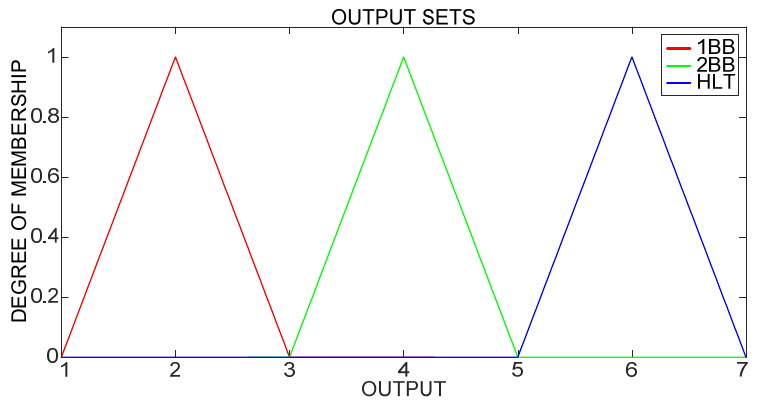
Figure 9. Fuzzy sets entries based on the Tamura definition of contrast.